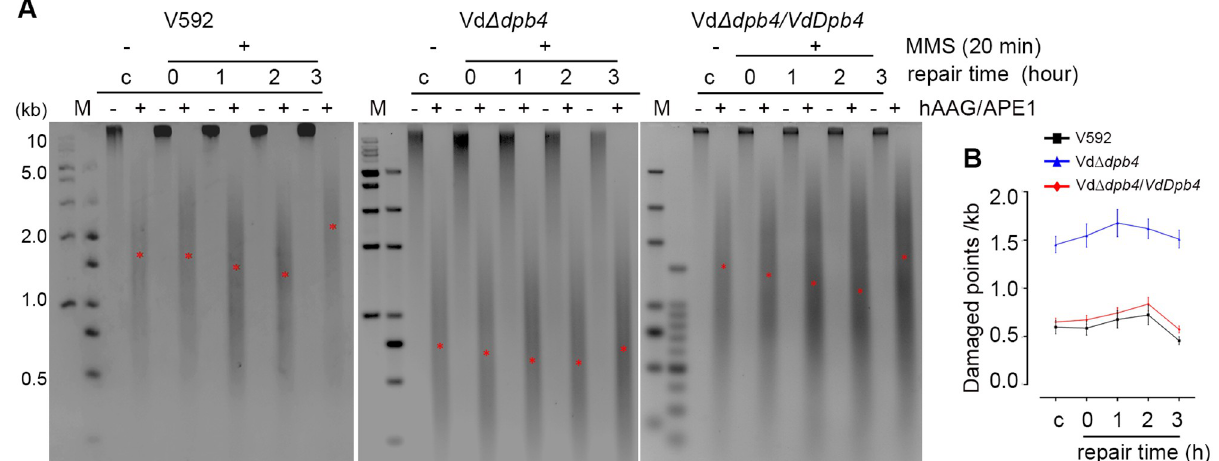
Fig 3. VdDpb4 is essential for resistance to DNA damage repair. A. The depletion of VdDpb4 dramatically inhibited genome-wide BER. A representative gel shows the repair time course in WT, the Vd Δ dpb4 mutant and complementation Vd Δ dpb4/VdDpb4 strains. M: marker DNA size standard; c: untreated cells; 0–3: cells damaged with MMS for 20 min; 1–3: repair time course in hours. Positions of the approximate median migration distance of the fragments in each lane are shown with red asterisks ( � ). B. The number of damaged DNA for each kilobase was calculated according to the average length obtained from the median migration distance. Error bars represent standard deviations from three independent experiments.